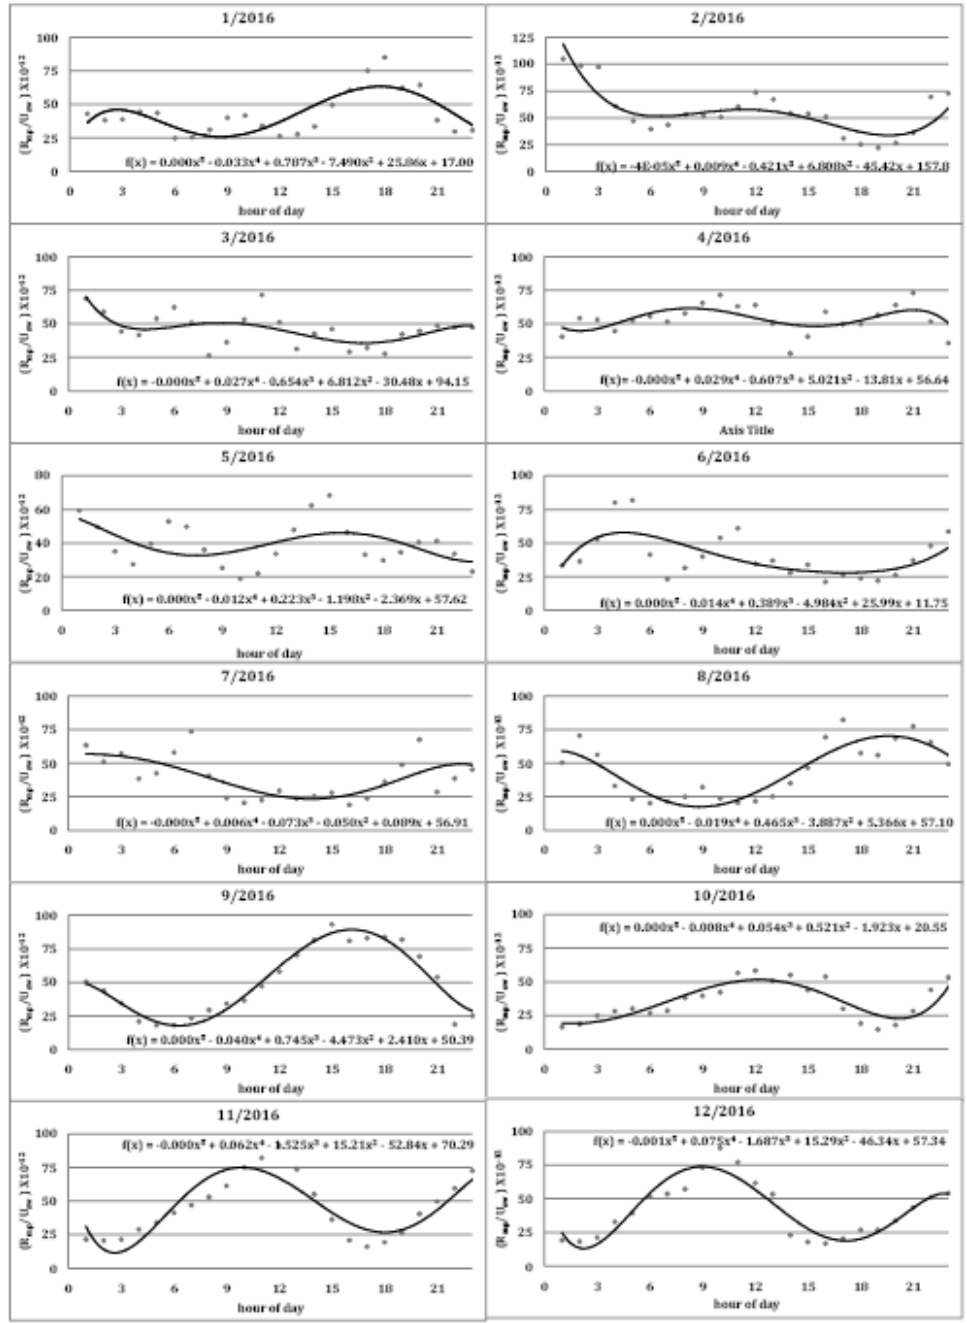
Fig. 6: Monthly median of (Rmp /Usw) for year